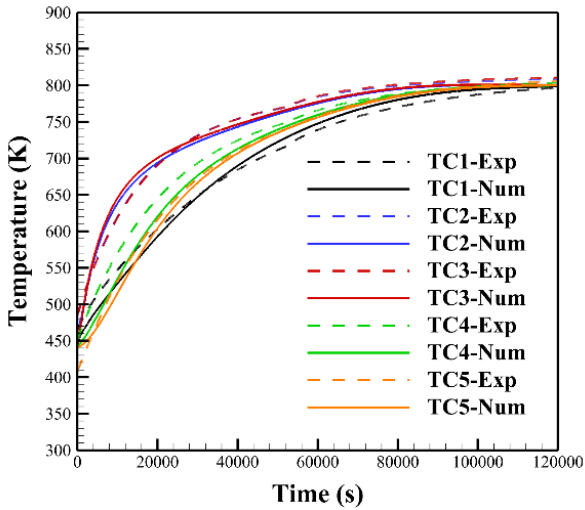
Figure 6. Validation of CFD simulations with the MRF model.